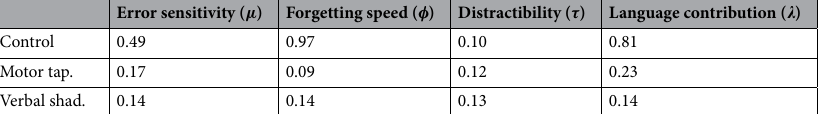
Table 1. Values of the parameters of the models that produce the best fit of the data on the WCST indices, for the control and experimental groups, reported in 47